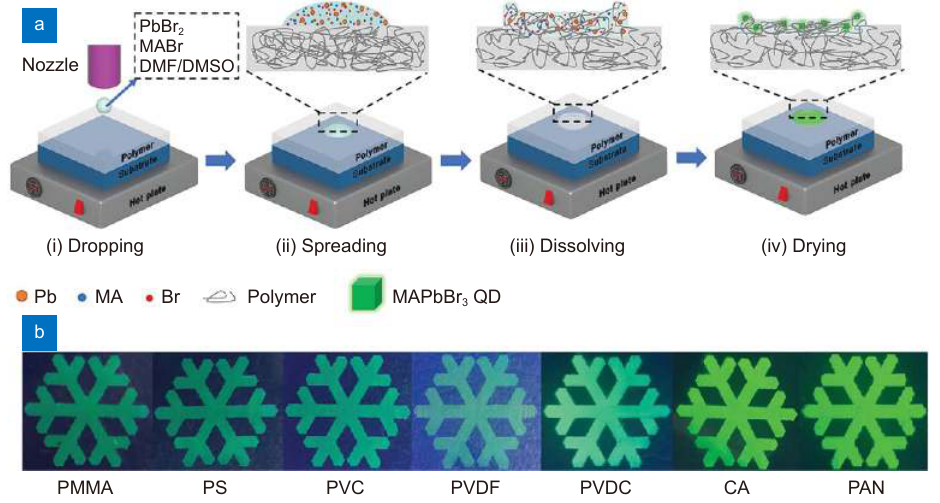
Fig. 9 | ( a ) Schematic diagram of the in situ inkjet printing strategy. ( b ) The optical images of printed PQD patterns on different polymer sub- strates under UV light. Figure reproduced with permission from ref. 69 , John Wiley and